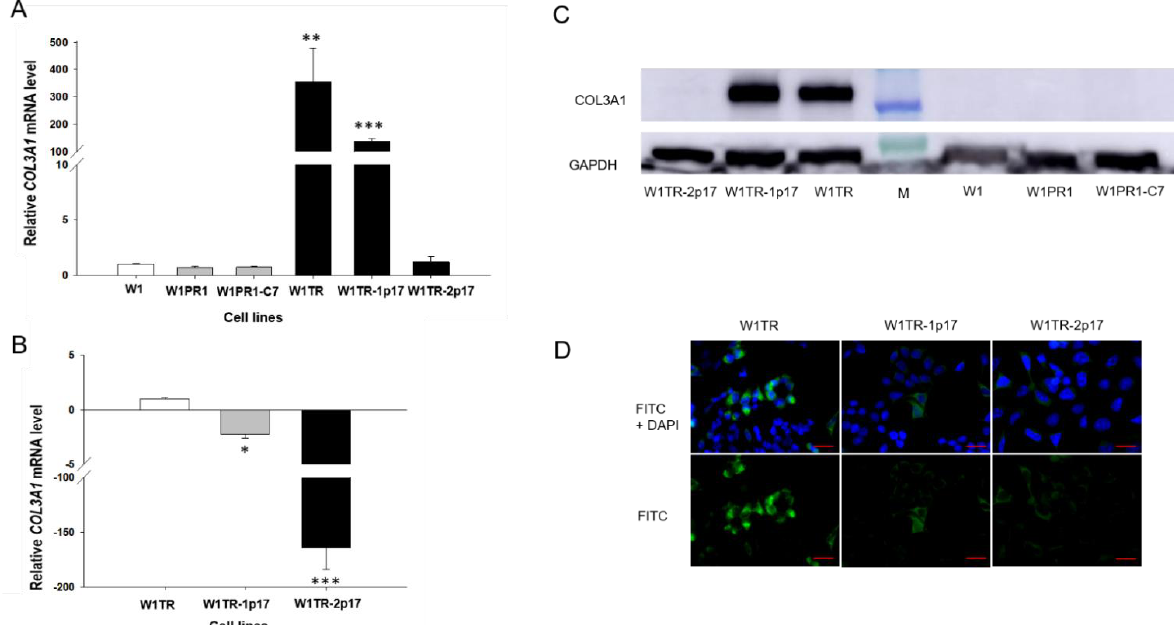
Figure 5. ( A ) Q-PCR analysis of COL3A1 transcript expression in the W1, W1PR1, W1PR1-C7, W1TR, W1TR-1p17, W1TR-2p17 cell lines. The figure presents the relative gene expression in the resistant cell lines with respect to that in the sensitive cell line, which has been assigned a value of 1. ( B ) Q-PCR analysis of COL3A1 transcript in the W1TR, W1TR-1p17 and W1TR-2p17 cell lines.